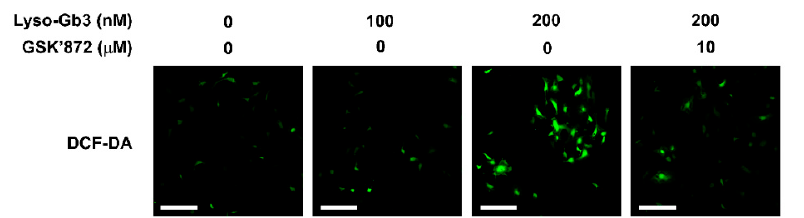
Figure 2. Association of lyso-Gb3 with ROS generation. Lyso-Gb3 treatment increased ROS production in a dose-dependent manner. GSK’872 treatment significantly reduced lyso-Gb3-induced ROS. Representative fluorescence images of lyso-Gb3-induced podocytes stained with 2 ′ ,7 ′ dichlorofluorescein (DCF-DA). Magnification, 20×; bar = 200 μ M.